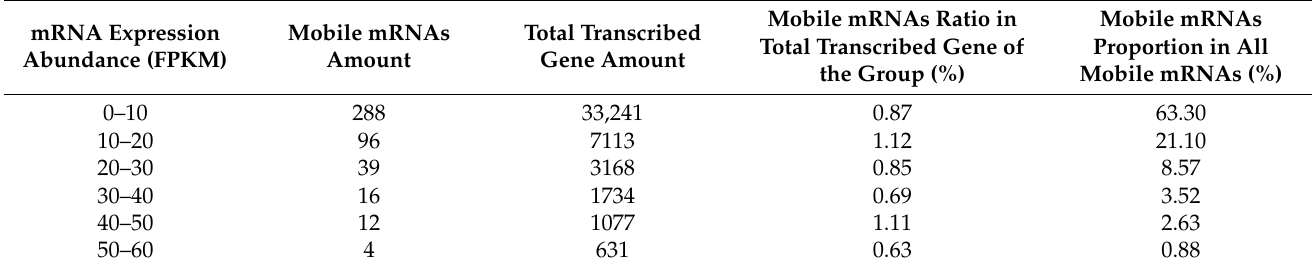
Table 3. Gene expression abundance and transfer ratio in the rootstock of 9901/YJ.